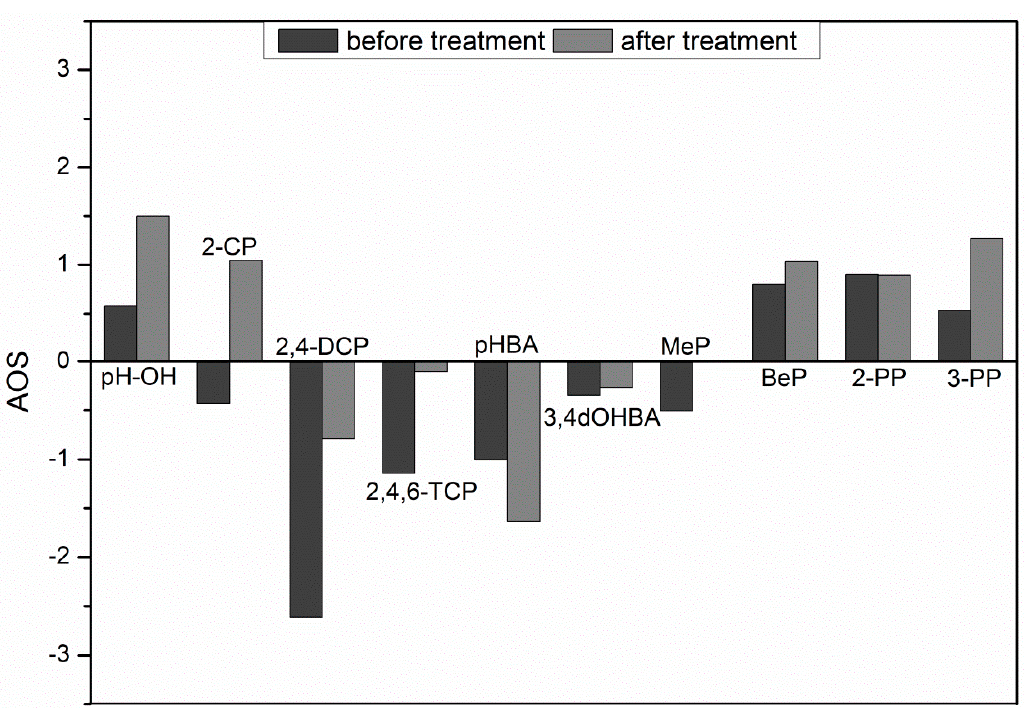
Figure 9. Average oxidation states for samples before and after treatment.